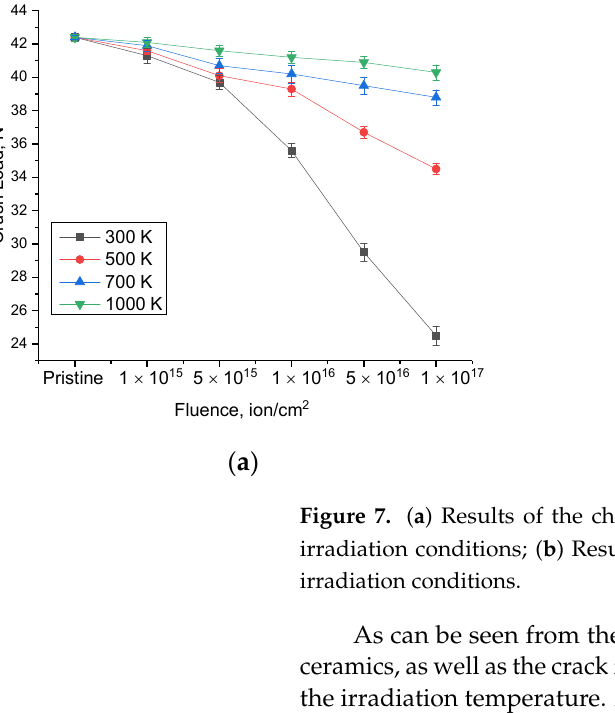
( b ) Figure 8. ( a ) Results of changes in the thermal conductivity of ceramics depending on the irradia- tion conditions; ( b ) Results of thermal conductivity losses depending on the irradiation conditions. An analysis of changes in thermal conductivity indicates, under high-dose irradia- tion, the formation of a defective fraction and an increase in the crystal lattice defor- mation, which leads to the creation of additional obstacles to heat transfer, and, conse-